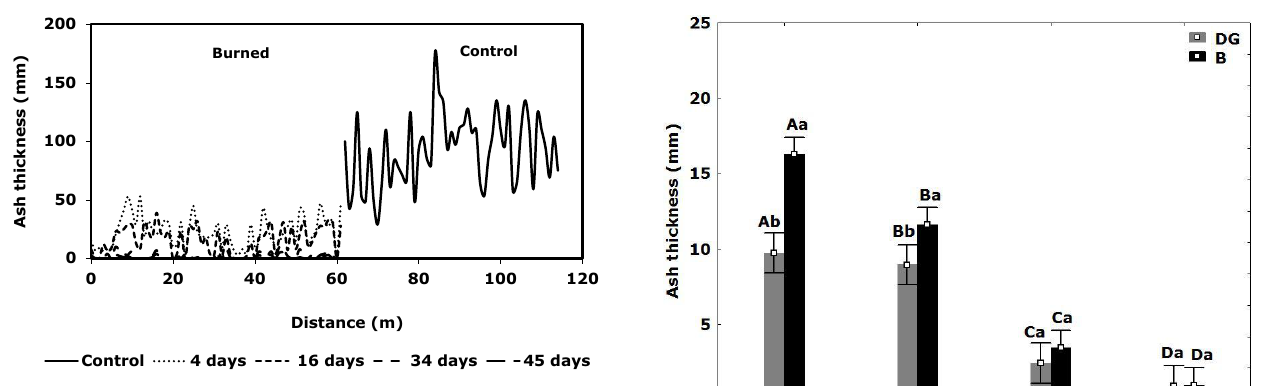
Fig. 5. Litter and ash thickness across the slope transects in the different measurement periods (burned) and control area. The correlations only consider burned area. (Control n = 53, Burned plot n = 60).